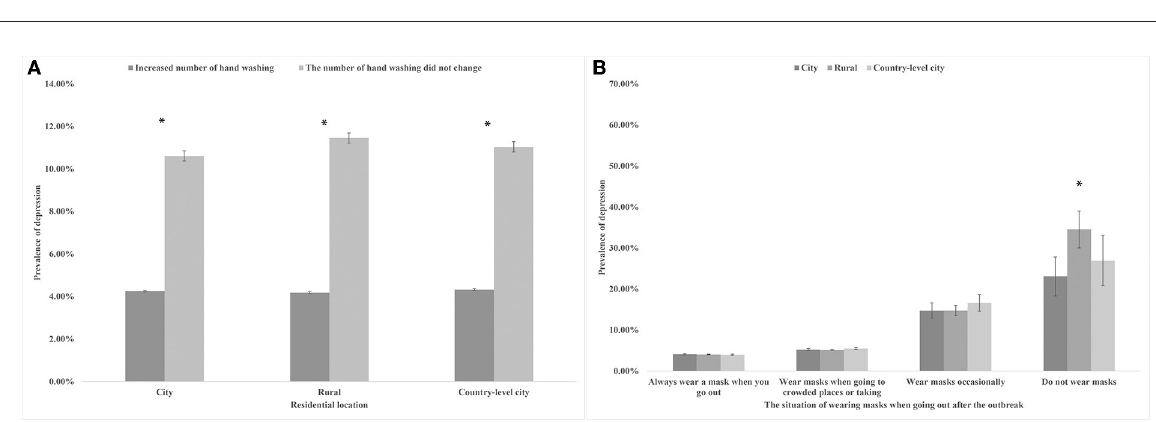
China. The prevalence of depressive symptoms in participants was shown in Figure 1 by gender and home region.